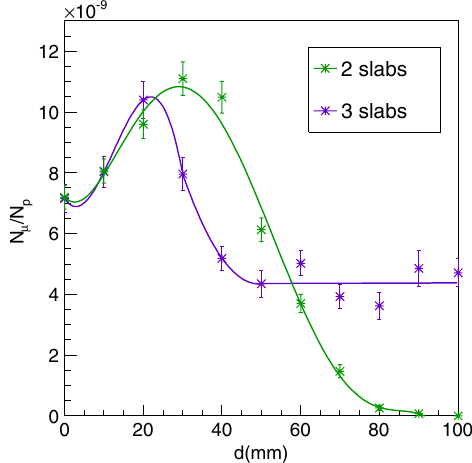
FIG. 6. Contribution of both materials to the surface muon production. Different colors represent the material in which the parent pion was